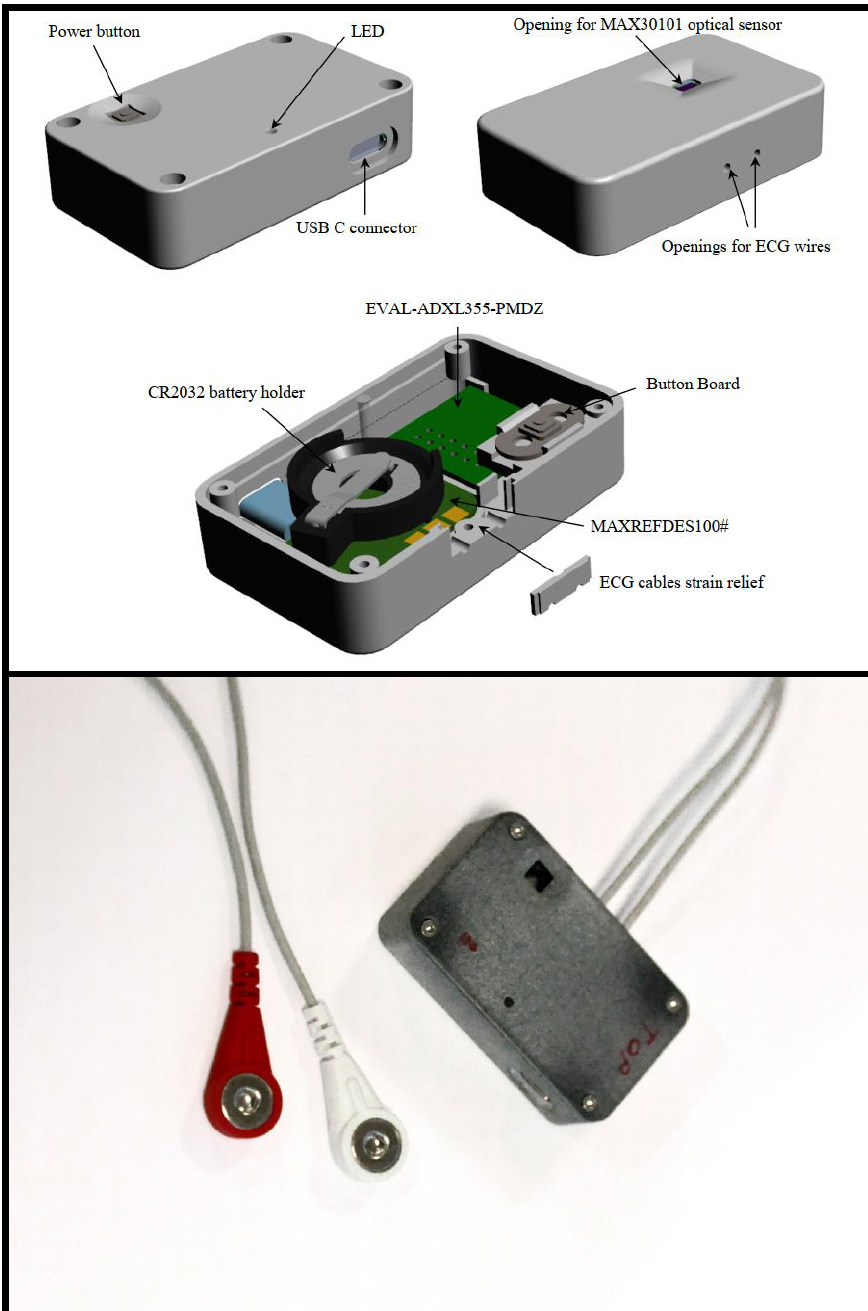
Figure 2. Device used in data acquisition including 3-axis accelerometer, 3-axis gyroscope and single lead ECG for R-peak extraction. The optical sensor is not used in this